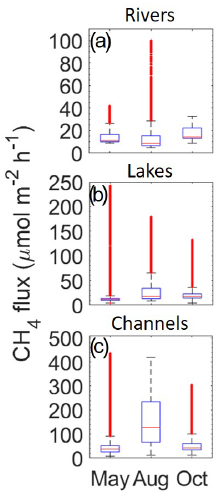
Figure 3. Calculated CH 4 flux (µmolm − 2 h − 1 ) data from the three seasonal campaigns: May, August and October for rivers (a) , lakes (b) and channels (c) . The blue boxes represent lower (25%) and upper (75%) quartiles, with the whiskers marking the lowest and highest data point within a distance of 1.5 times the interquartile range from the respective quartile. Red “+” signifies points out- side of these boundaries. Median values are shown as horizontal red lines. All data are included ( n > 200000 for each season), including the hot spot and day–night cycle